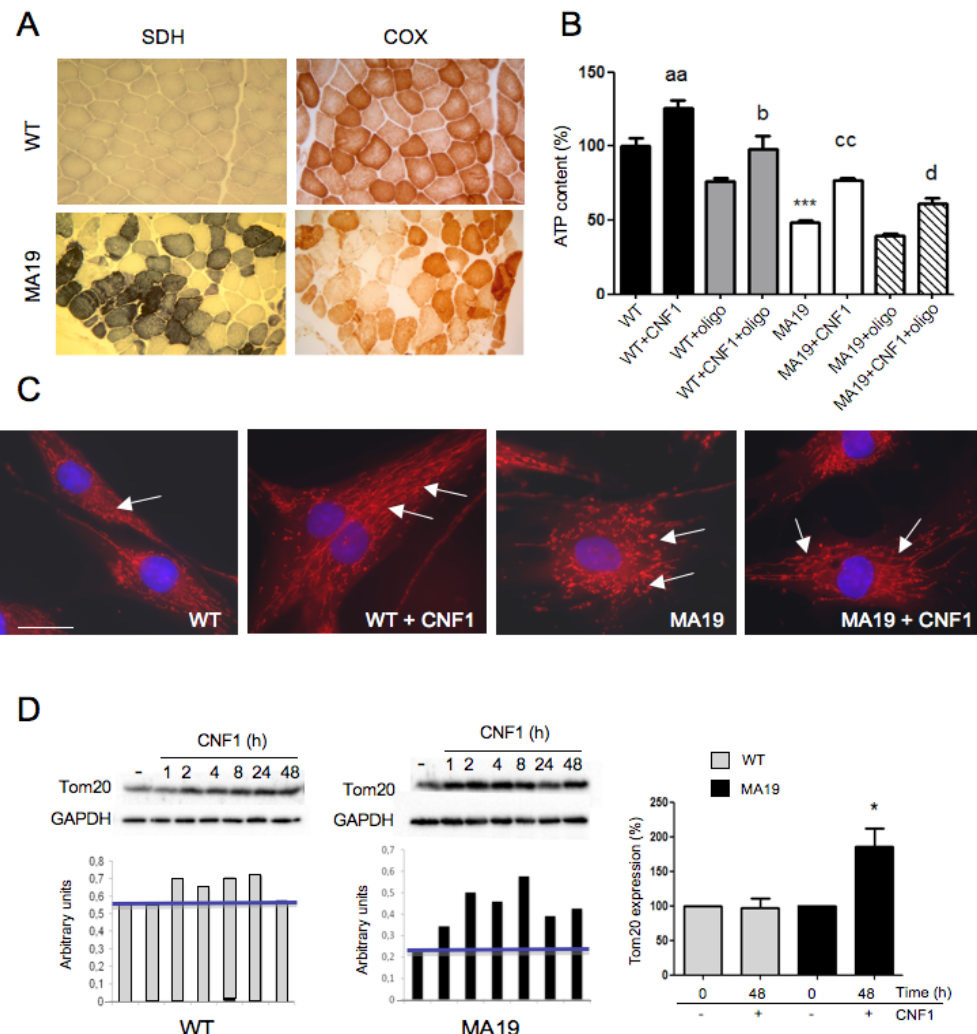
Figure 1. CNF1 effects ATP content and mitochondrial morphology and mass in fibroblasts from a patient carrying a mitochondrial disease. ( A ) Muscle pathology in a control patient (WT): the muscle looks normal without mitochondrial proliferation or COX-deficient fibers. Muscle pathology in the MA19 patient: SDH histochemistry shows mitochondrial proliferation with classic RBF, which appeared pale with the COX staining (magnification 20 × ); ( B ) Graph showing the relative increase of ATP content in WT and MA19 fibroblasts after 48 h of exposure to CNF1, either in the presence or absence of oligomycin added during the last 4 h of incubation. Data are expressed as percentages and represent mean ± standard error of the mean (SEM) from at least three independent experiments. *** p < 0.001 for WT versus MA19; aa p < 0.01 for WT versus WT + CNF1; b p < 0.05 for WT + oligo versus WT + CNF1 + oligo; cc p < 0.01 for MA19 versus MA19 + CNF1; d p < 0.05 for MA19 + oligo versus MA19 + CNF1 + oligo; ( C ) Fluorescence micrographs of WT and MA19 fibroblasts treated with CNF1 for 48 h and then stained with the mitochondrial dye Mitotracker (red) and with Hoechst 33258 (blue). Note that CNF1 treatment modifies the mitochondrial network in MA19 fibroblasts, rescuing the mitochondrial morphology of untreated WT fibroblasts. Bar = 10 μ m; ( D ) Immunoblots showing representative Western blot experiments in whole cells lysates from control WT and MA19 fibroblasts. The amount of Tom20 is normalized as a function of GAPDH (bottom histograms). The histogram on the right shows, in percentage, the relative increase in Tom20 expression for both cell types (untreated WT and MA19 at time 0 = 100) following 48 h of toxin challenge, both normalized to their controls (treatment at time 0 = 100%). Data are represented as the means ± SEM from three independent experiments. * p < 0.05 for MA19 versus MA19 +